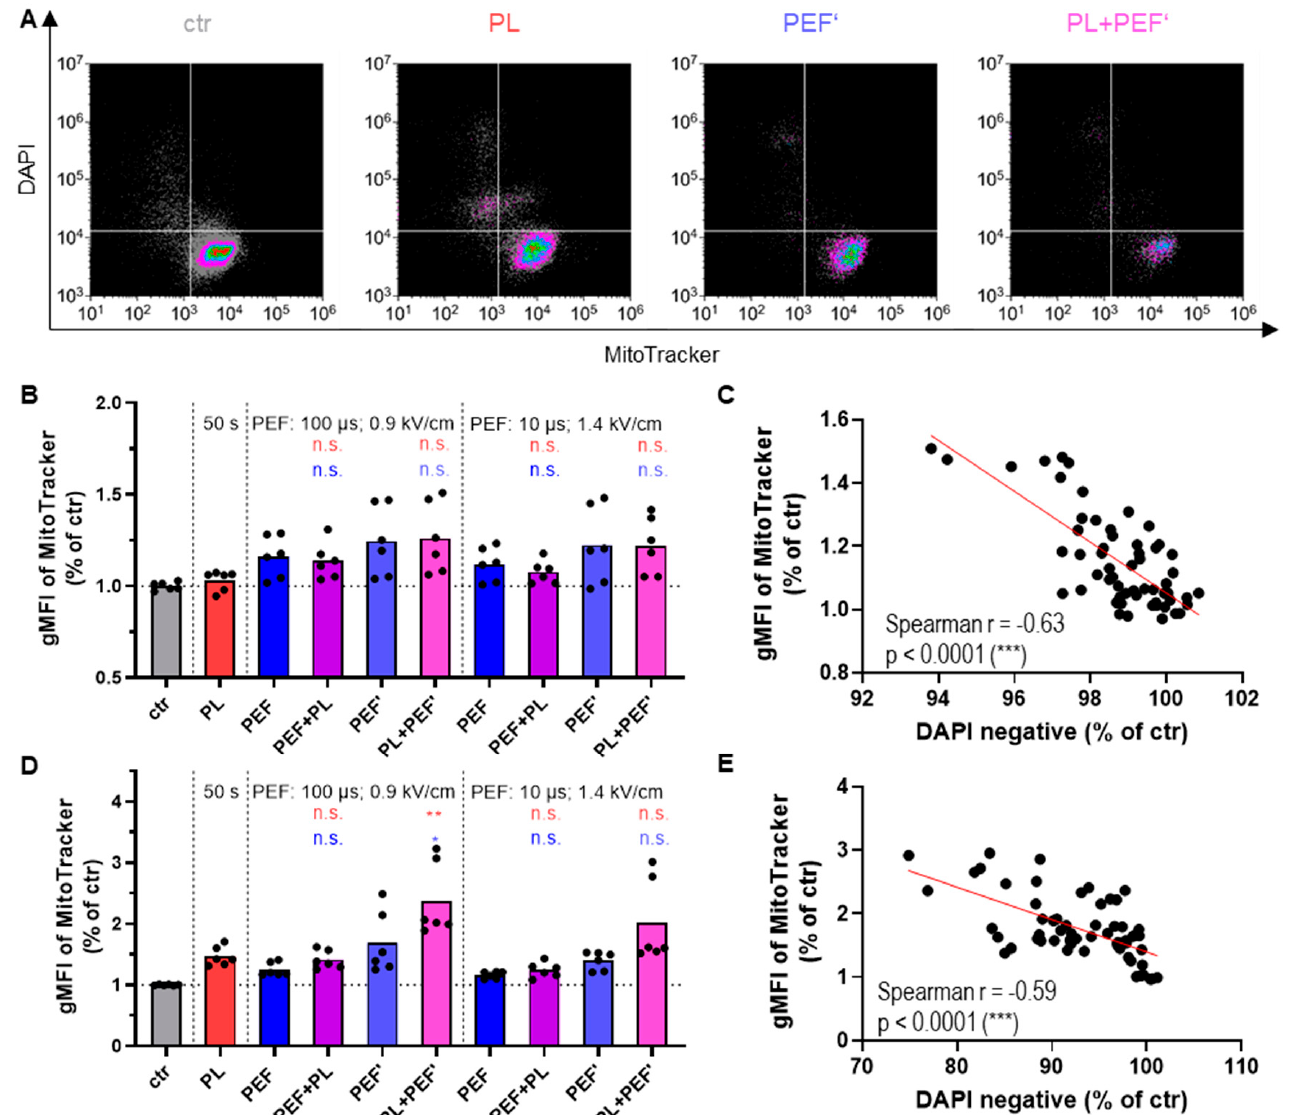
Figure 3. Mitochondrial membrane potential of Jurkat cells in DMEM after plasma and PEF treatment. MitoTracker Red FM was used to analyze all cells’ mitochondrial membrane potential plotted against the DAPI signal after 24 h ( A ). The mitochondrial membrane potential of the viable cells is displayed after 4 h ( B ) and 24 h ( D ). Data are shown as one representative ( A ) or mean from three independent experiments with several replicates each ( B , D ). The analysis for mitochondrial membrane potential in relation to the DAPI negative cells was done using nonparametric, two-tailed Spearman correlation with 95% confidence intervals for the 4 h ( C ) and 24 h ( E ) measurements. The fluorescence intensity of the dyes was evaluated via flow cytometry. One-way ANOVA with Turkey’s multiple comparison test was performed (*: p < 0.05, **: p < 0.01). ctr: control; PL: plasma; PEF: pulsed electric field; PEF’: cells were seeded into 96-well plates before being transferred into cuvettes; n.s.: not significant; gMFI: fluorescence intensity of the geometric